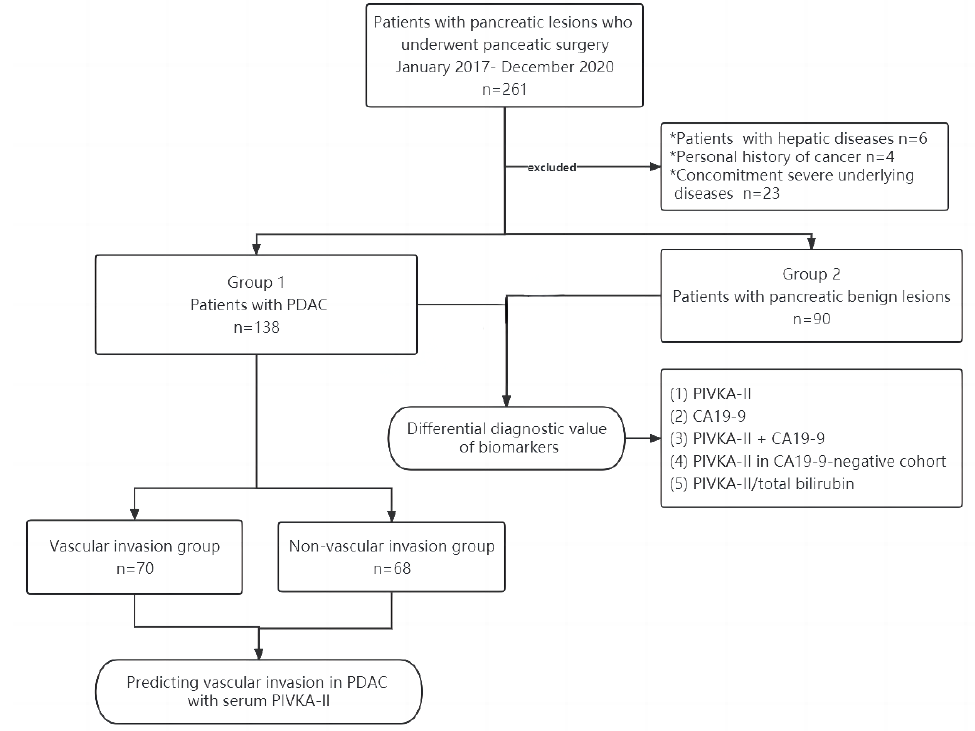
Figure 1. Flowchart of case selection in this study. PDAC, pancreatic ductal adenocarcinoma; CA19-9, carbohydrate antigen 19–9; PIVKA-II, protein induced by vitamin K absence-II.